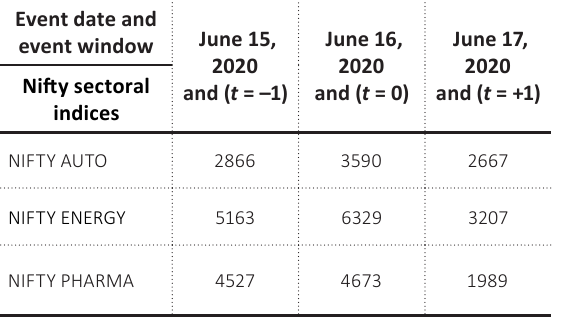
Table 3. Number of intraday tick-by-tick unique